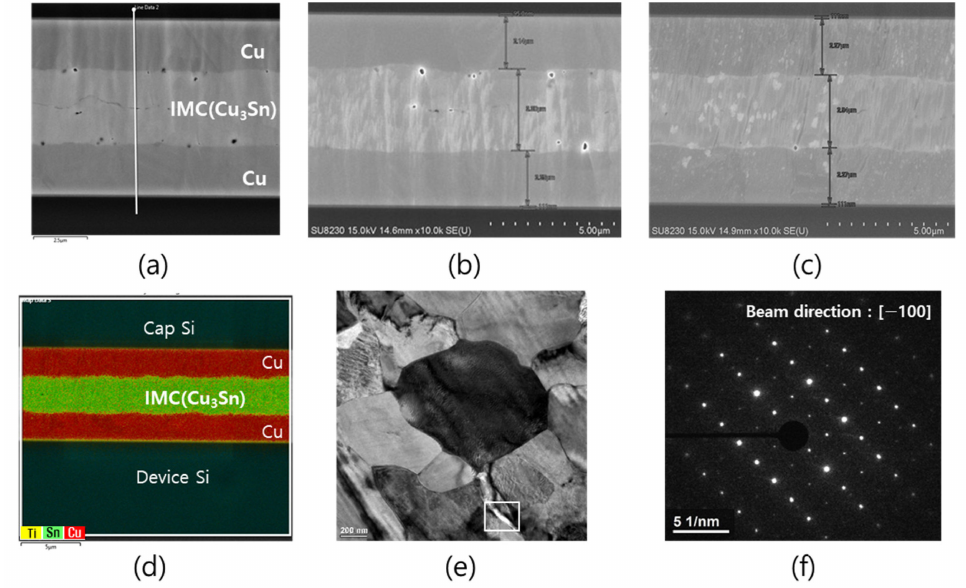
Figure 6. Cross sectional SEM micrograph of the bonded interface at bonding forces of ( a ) 2.5 kN, ( b ) 5 kN, and ( c ) 10 kN. ( d ) EDS map, ( e ) TEM micrograph, and ( f ) diffraction analysis results of sample ( c ) showing that Cu 3 Sn IMC has an orthorhombic crystal structure with lattice parameters of a = 5.49, b = 4.32, c = 4.74 Å